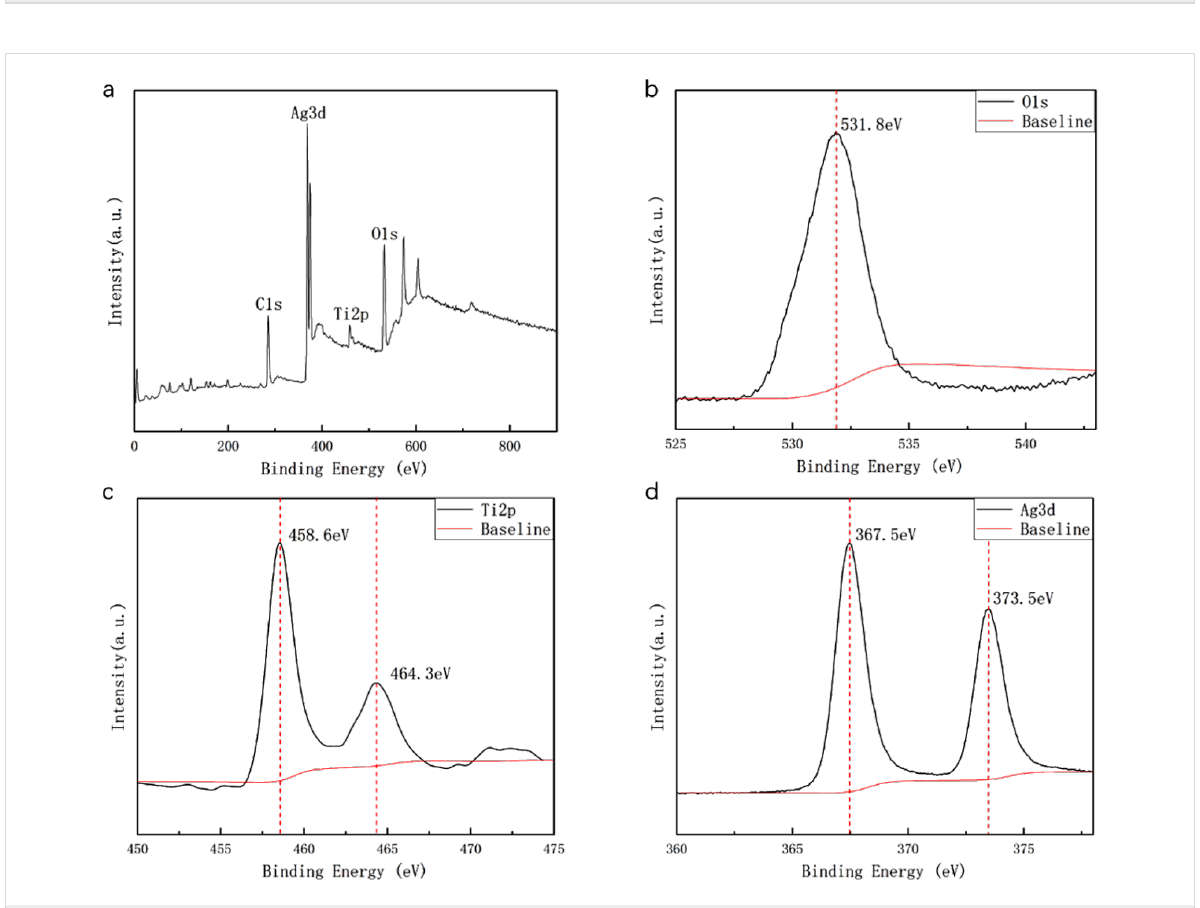
Figure 5: XPS spectrum of AFT3: (a) Survey spectrum, and details of the regions related to (b) O 1s, (c) Ti 2p, (d) Ag